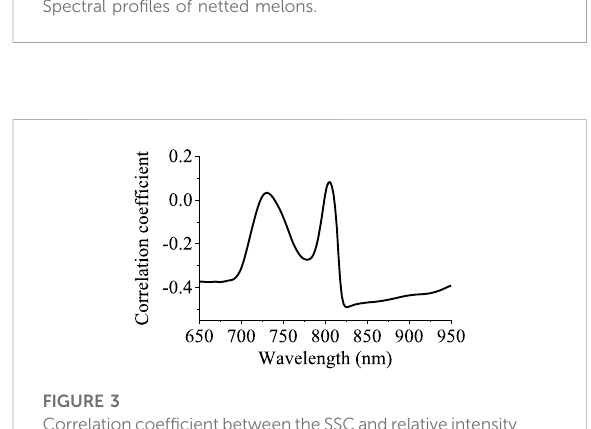
Correlationcoef fi cientbetweentheSSCandrelativeintensity of the hyperspectra of netted